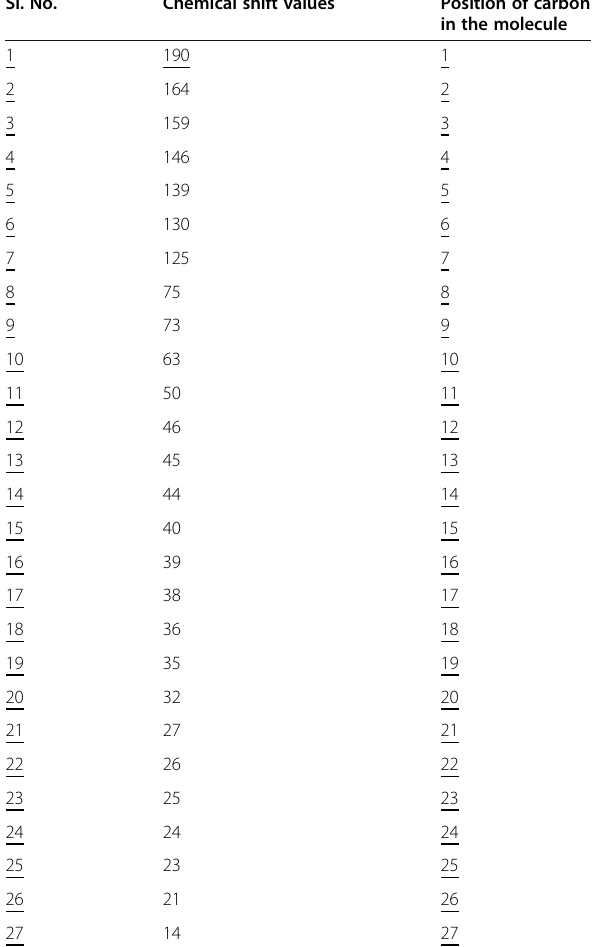
Table 7 13 C NMR in table format Sl.